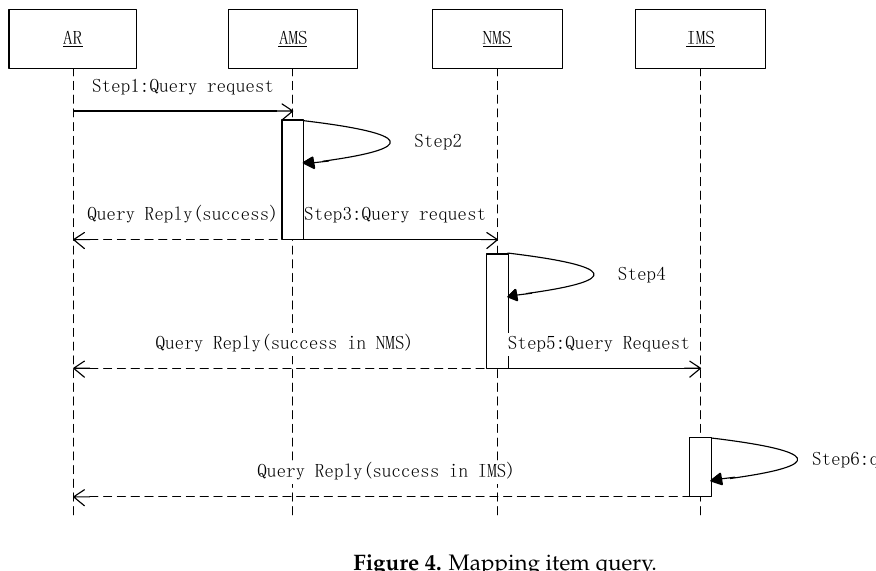
Figure 4. Mapping item query.